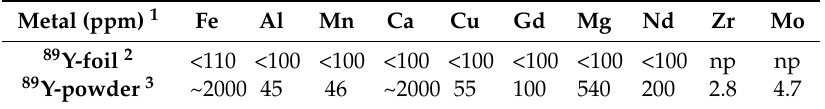
Table 1. Trace metal analysis for 89 Y-foil and powder (Certificate of